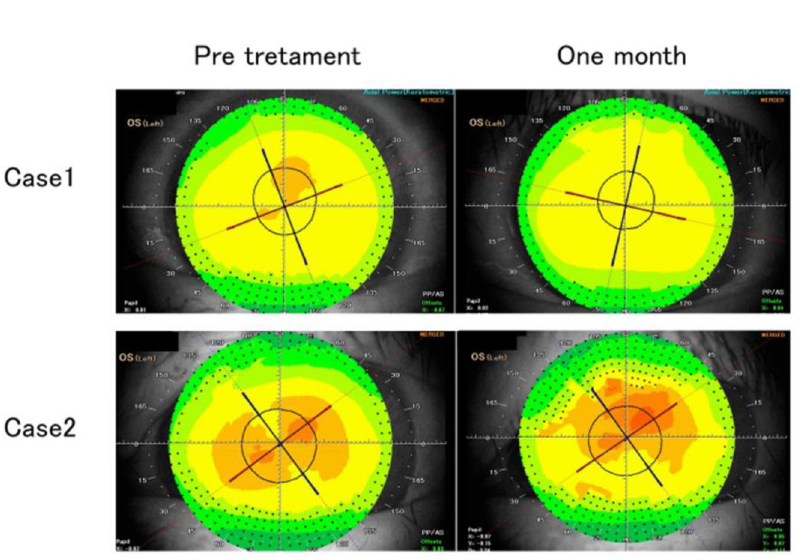
Fig 4. Case 1: Postoperative topography showing change in axis with improvement in focal steepening in the superior corneal hemisphere. Case 2: Postoperative topography showing increased magnitude of astigmatism and decreased uncorrected visual acuity 1 month